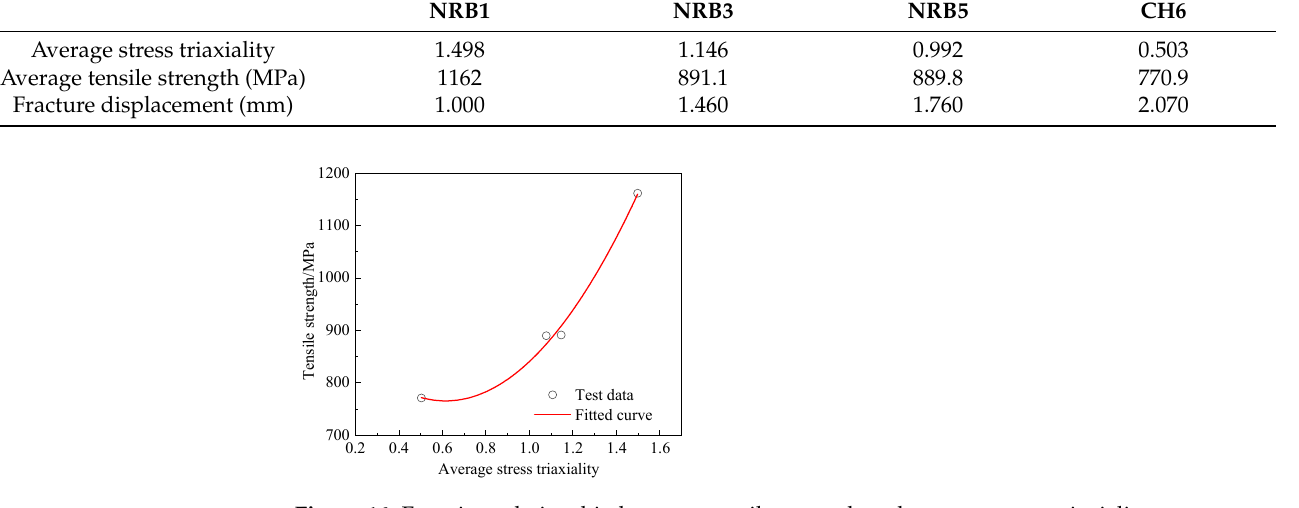
Figure 16. Function relationship between tensile strength and average stress triaxiality. Table 4. Average stress triaxiality and tensile strength of notched specimens.